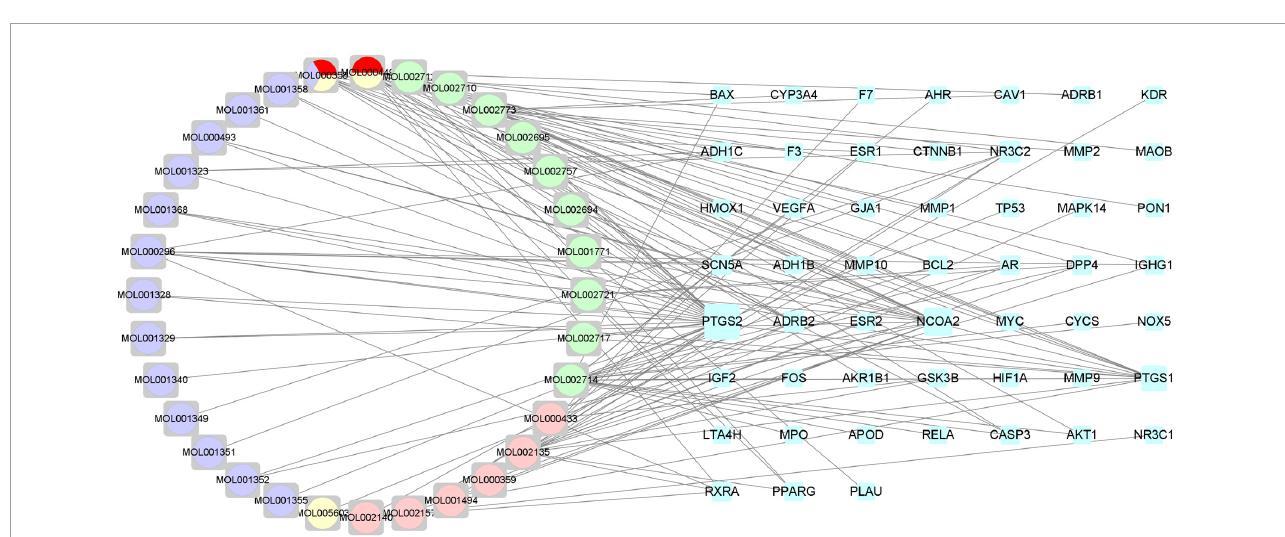
FIGURE3 Chinese medicines-active ingredients-intersection targets network. The blue nodes on the right represent the intersection targets. The round nodes on the left represent all the herbs of THD. The pink nodes represent Rhizoma Ligustici. The green nodes represent Flos Carthami. The red nodes represent Radix Angelicae Sinensis. The yellow nodes represent Radix Clematis. The purple nodes represent Semen